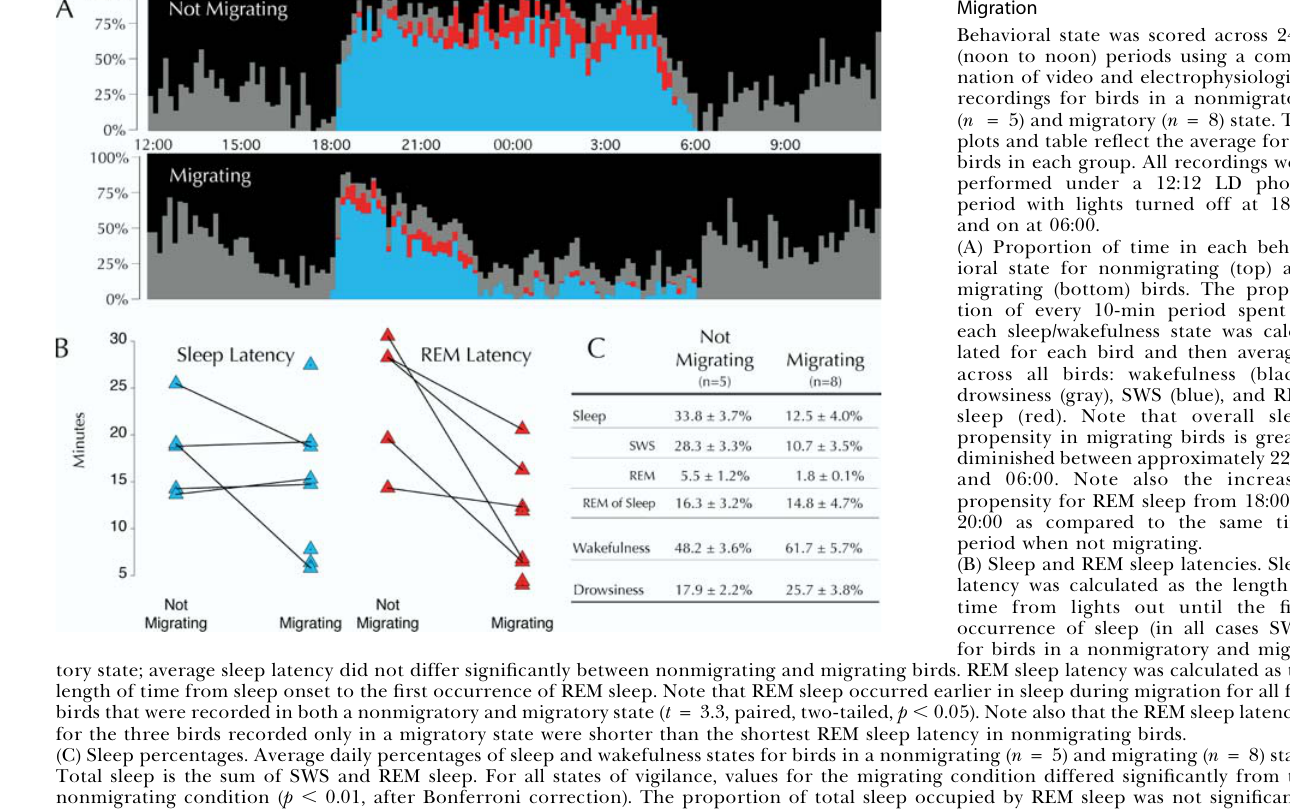
tory state; average sleep latency did not differ significantly between nonmigrating and migrating birds. REM sleep latency was calculated as the length of time from sleep onset to the first occurrence of REM sleep. Note that REM sleep occurred earlier in sleep during migration for all five birds that were recorded in both a nonmigratory and migratory state ( t = 3.3, paired, two-tailed, p , 0.05). Note also that the REM sleep latencies for the three birds recorded only in a migratory state were shorter than the shortest REM sleep latency in nonmigrating birds. (C) Sleep percentages. Average daily percentages of sleep and wakefulness states for birds in a nonmigrating ( n = 5) and migrating ( n = 8) state. Total sleep is the sum of SWS and REM sleep. For all states of vigilance, values for the migrating condition differed significantly from the nonmigrating condition ( p , 0.01, after Bonferroni correction). The proportion of total sleep occupied by REM sleep was not significantly different between migratory